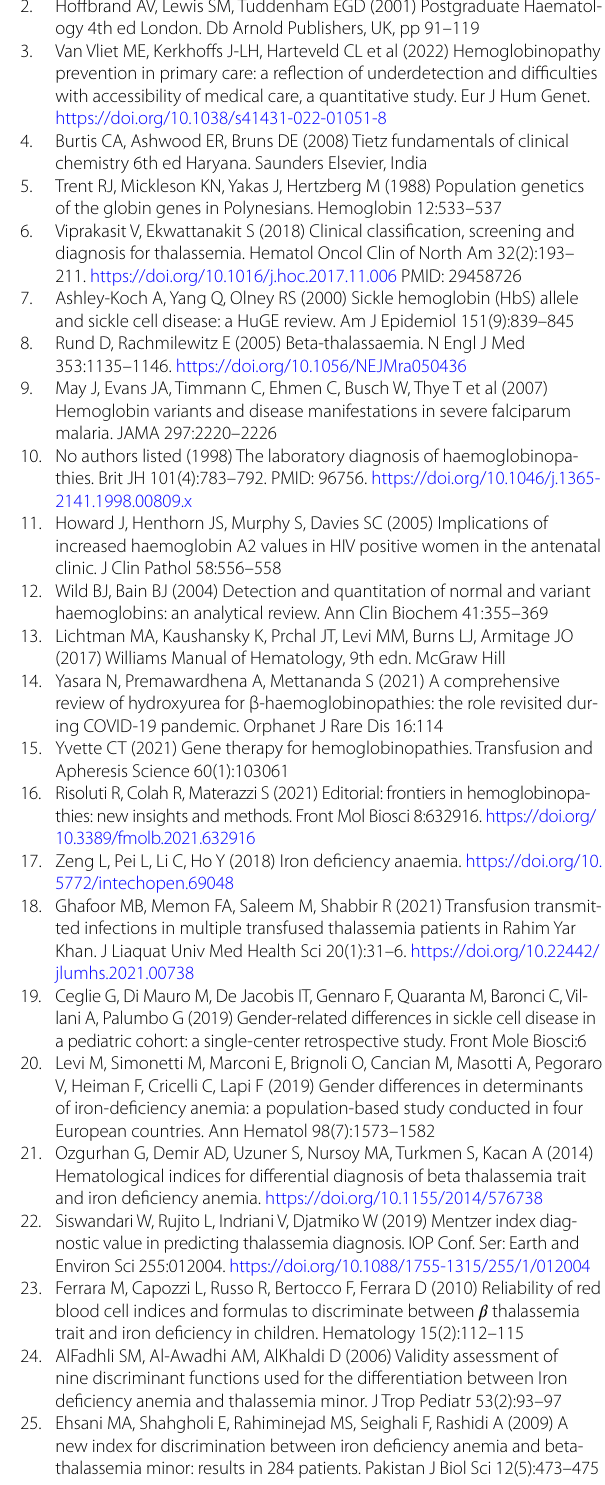
Additional file 1: Table S1. Adult reference ranges of blood indices. Table S2. Study groups and distribution of hemoglobinapathies among the study